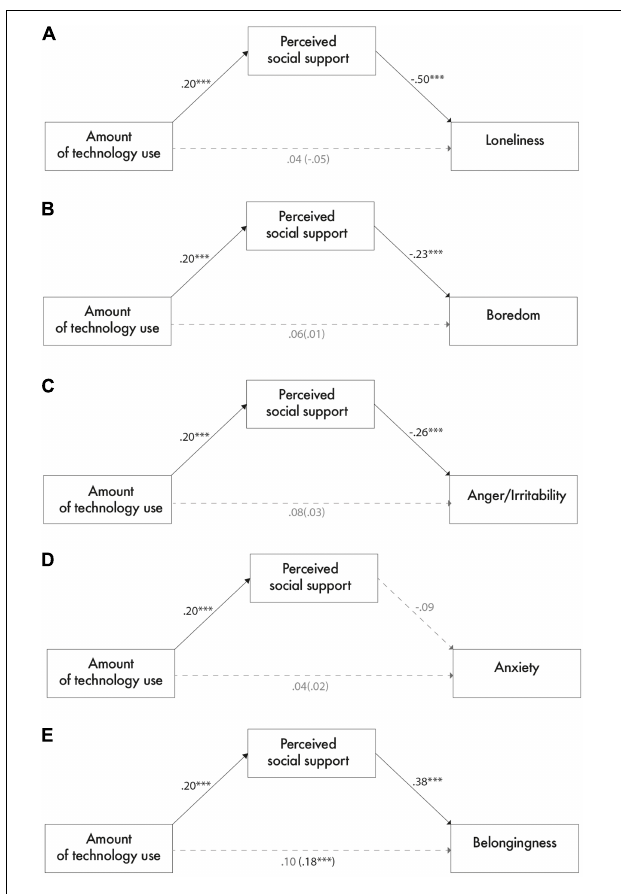
FIGURE 1 | Standardized regression coefficients for the indirect effects of technology usage during the lockdown on loneliness (A) , boredom (B) , anger and irritability (C) , anxiety (D) , and belongingness (E) through perceived social support. The total effect is in parentheses. *** p <